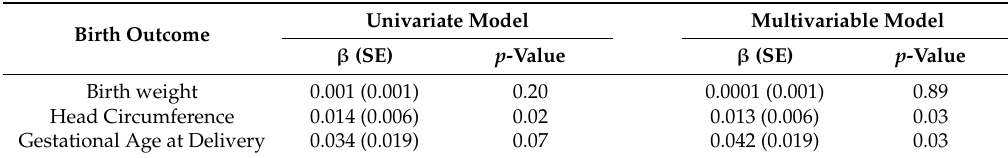
Table 4. Associations between mitochondrial DNA copy number (mtDNAcn) and birth outcomes: Linear regression